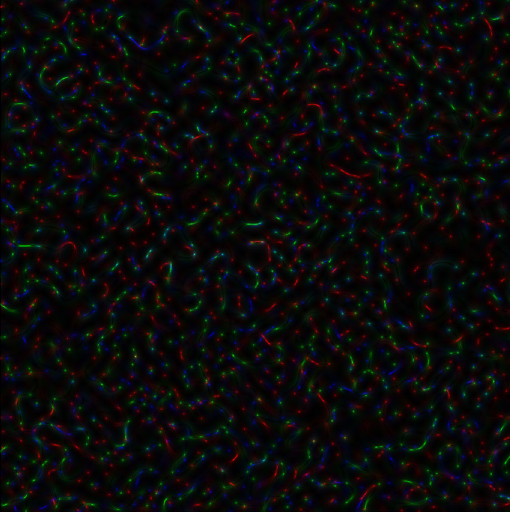
Figure 3b. Coloured s-LASCA images of GB-speckles, generated for other three SARS – CoV-2 genes (the gene#4, the gene#5 and the